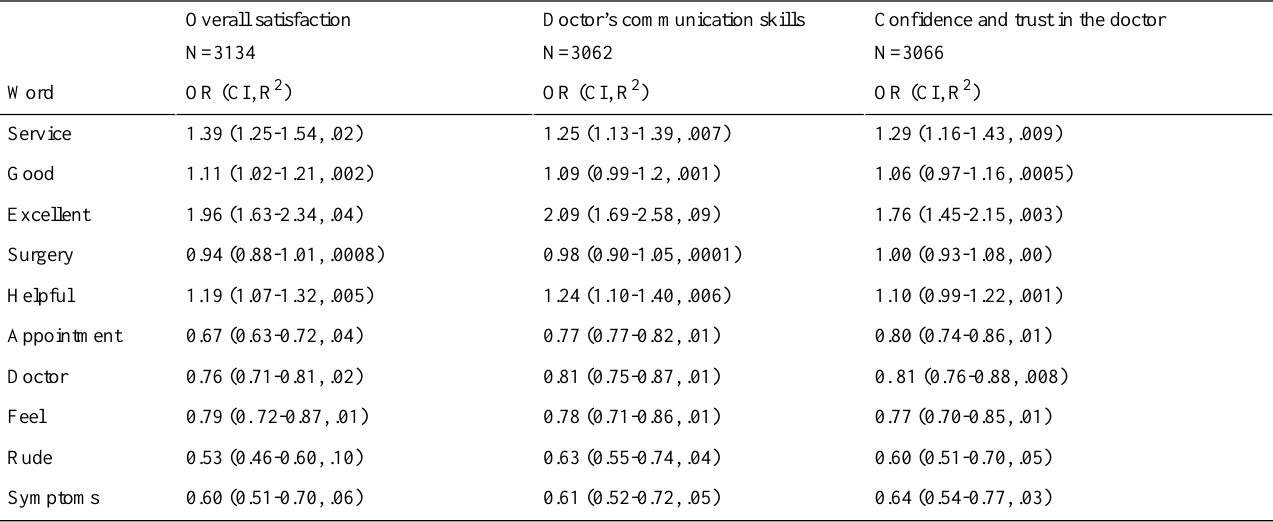
Table 1. Odds ratio (95% CI, R 2 value) for the occurrence of distinctive words corresponding to a one standard deviation increase in measures of patient